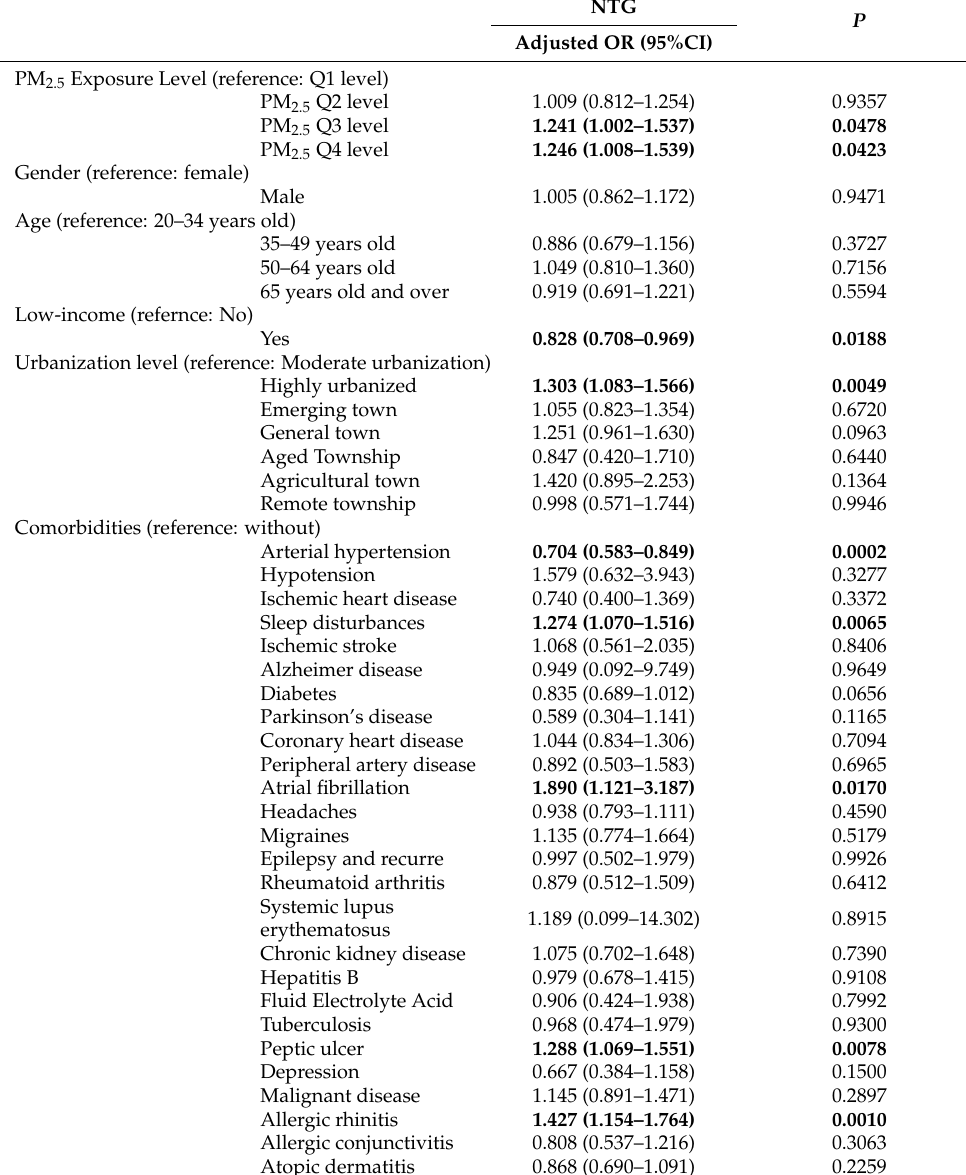
Table 3. Logic regression analysis PM 2.5 level between NTG and POAG.